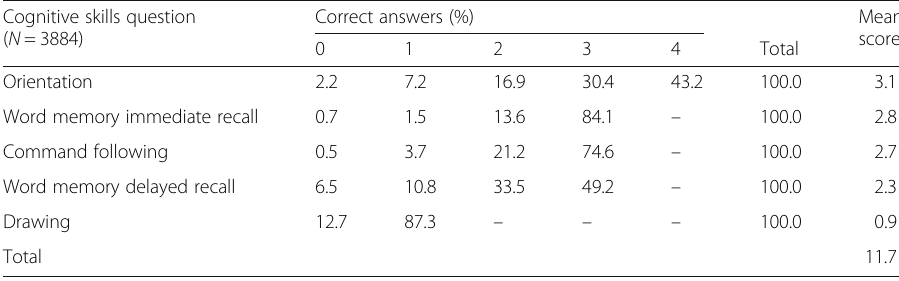
Table 1 Distribution of cognitive score by question Cognitive skills question ( N =